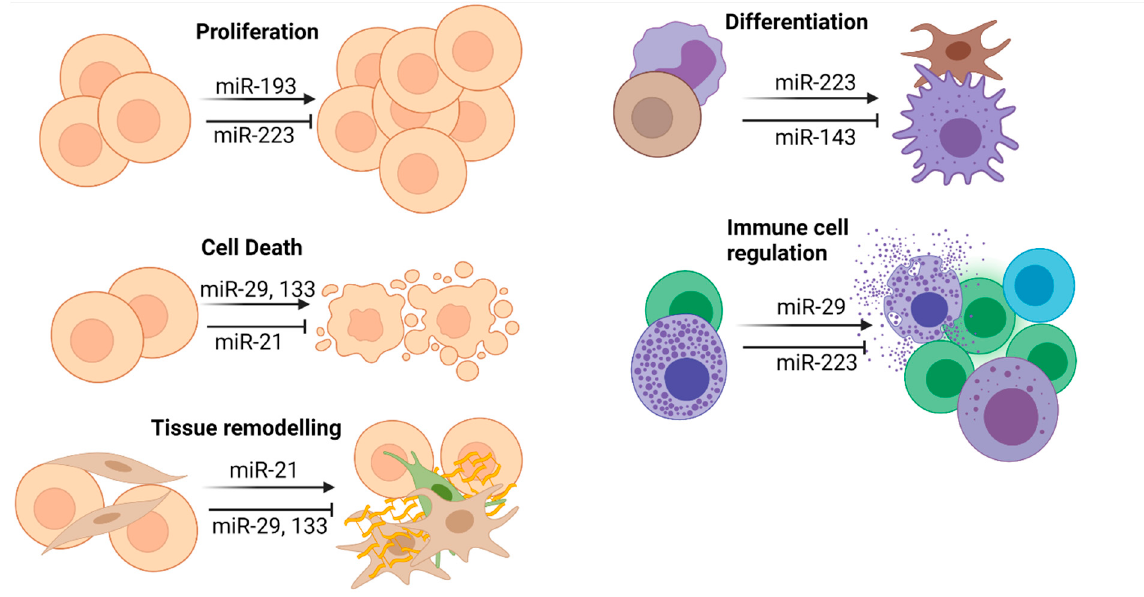
Figure 2. RISC/miRNA-dependent translational repression may induce or inhibit various oncogenic key functions, including proliferation, differentiation, cell death, immune cell regulation, and tissue remodeling/metastasis. Figure created with BioRender.com.